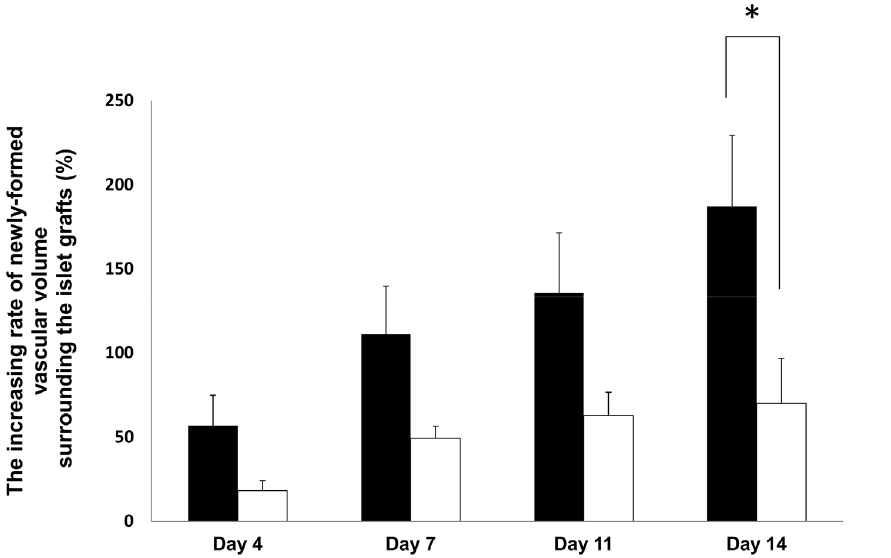
Figure 5. The increasing rate of newly-formed vascular volume surrounding the transplanted islets with and without tacrolimus. The increasing rate (against day 1) of newly-formed vascular volume surrounding the islets at 4, 7, 11, and 14 days after transplantation in the control group (black bar) and the tacrolimus-treated group (white bar) was calculated. All values are expressed as the means 6 SEM. *P , 0.05 in comparison to the control